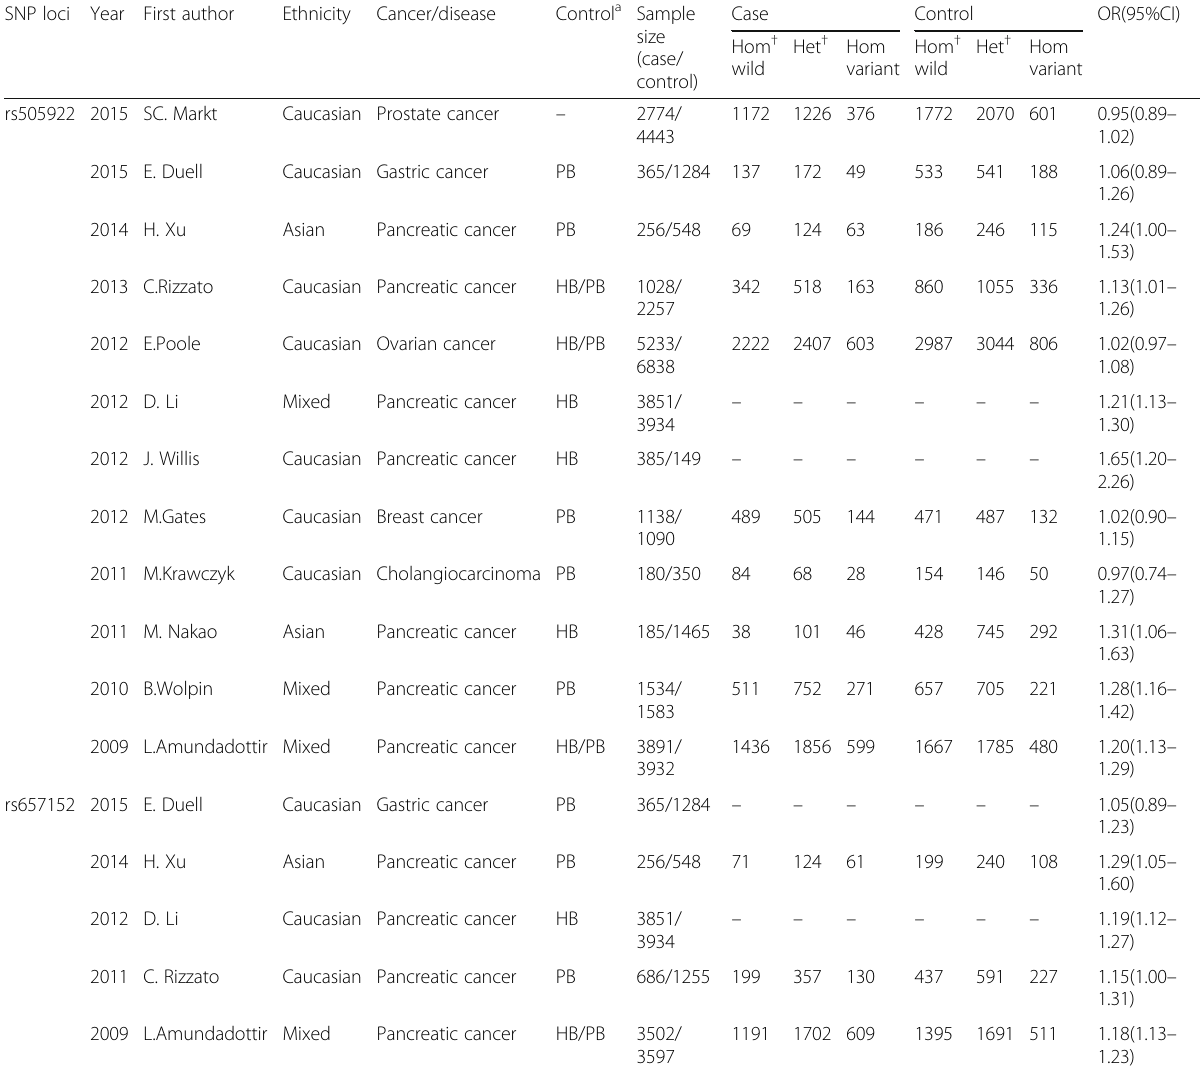
Table 1 Characteristics of the studies included in the meta-analysis of the association between SNPs and cancers SNP loci Year First